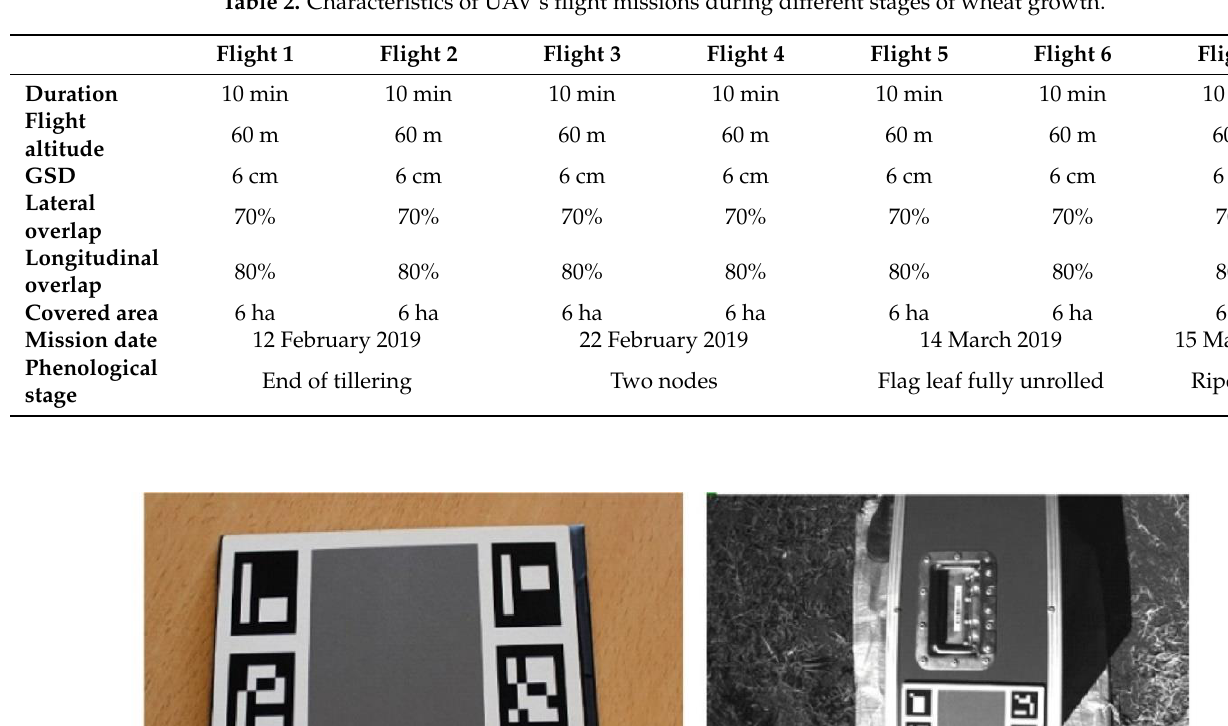
Table 2. Characteristics of UAV’s flight missions during different stages of wheat growth.